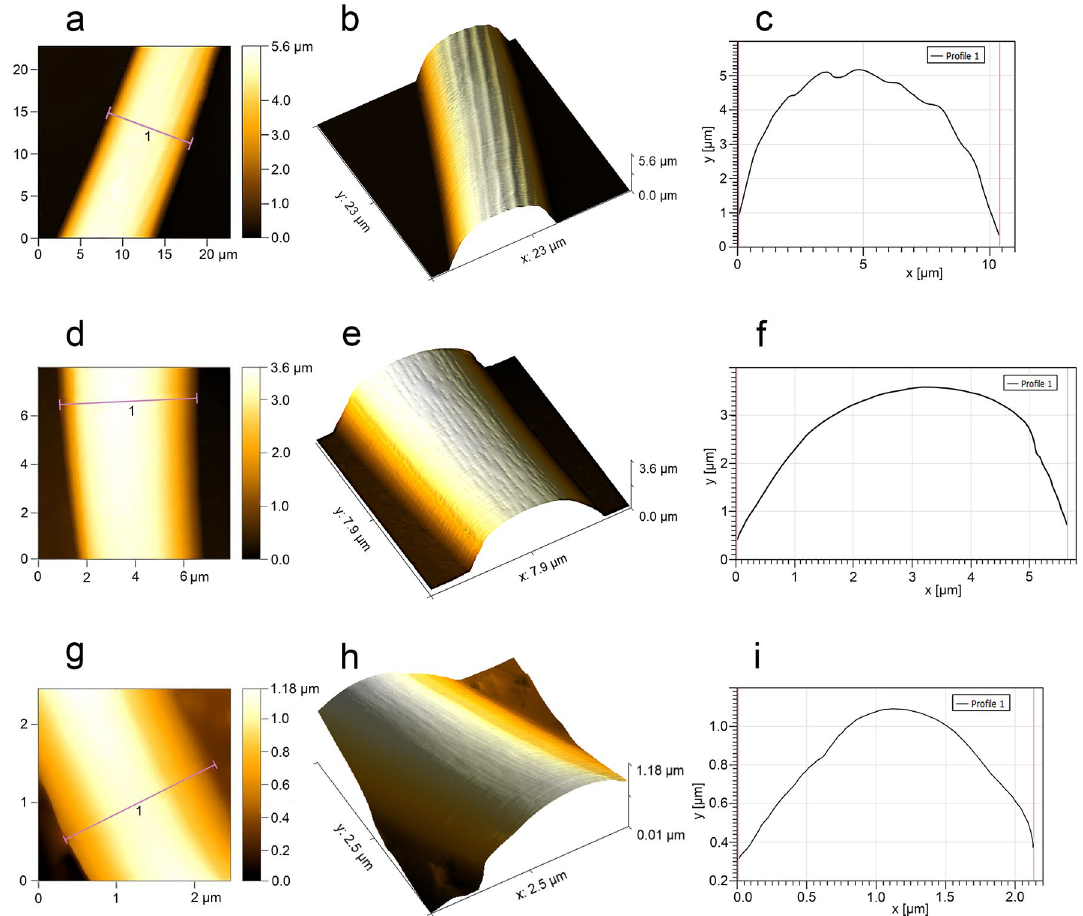
Figure 7. Micromorphology of selected types of sensilla ( L. occidentalis ) analyzed in AFM. Type A3: 2D view ( a ), 3D view ( b ) and surface profile ( c ); M5: 2D ( d ), 3D view ( e ) and surface profile ( f ); mic.: 2D ( g ), 3D view ( h ) and surface profile ( i ). Abbreviations are given in the text.